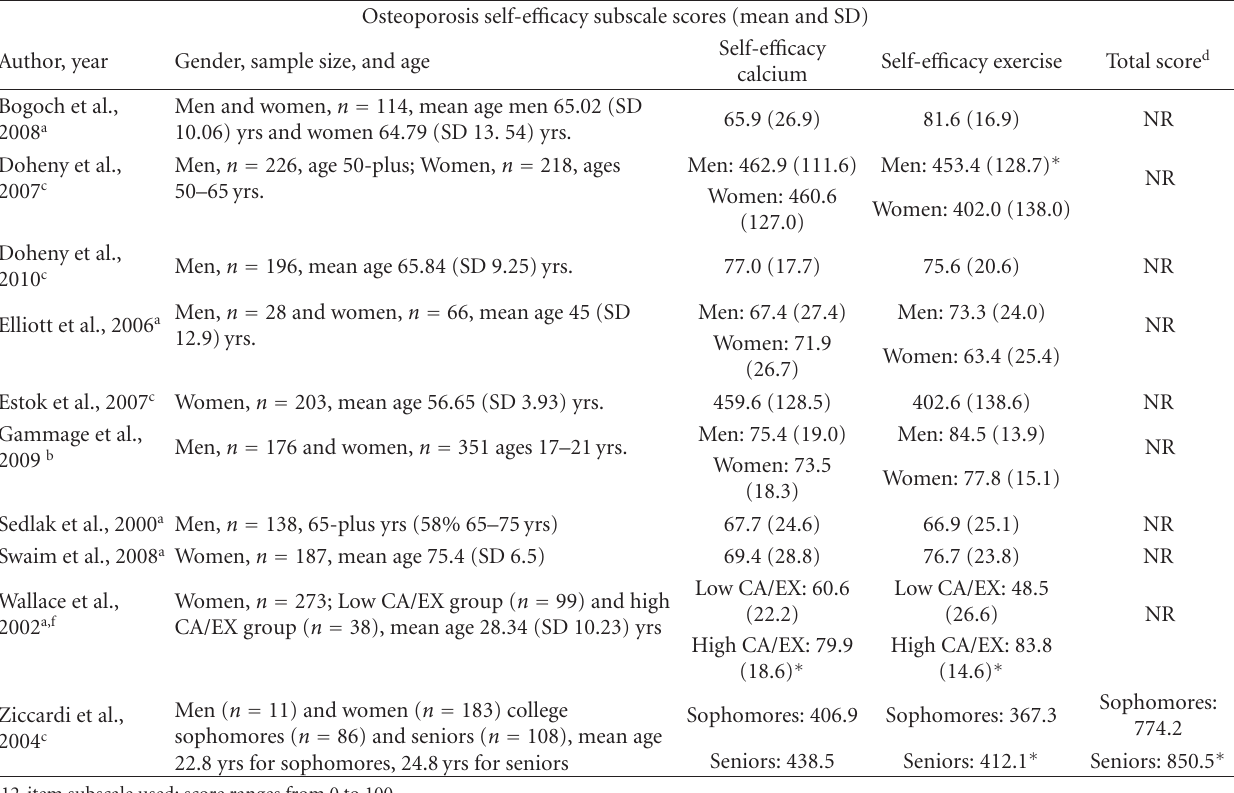
Table 2: Mean scores for osteoporosis self-e ffi cacy subscales of descriptive studies. Osteoporosis self-e ffi cacy subscale scores (mean and